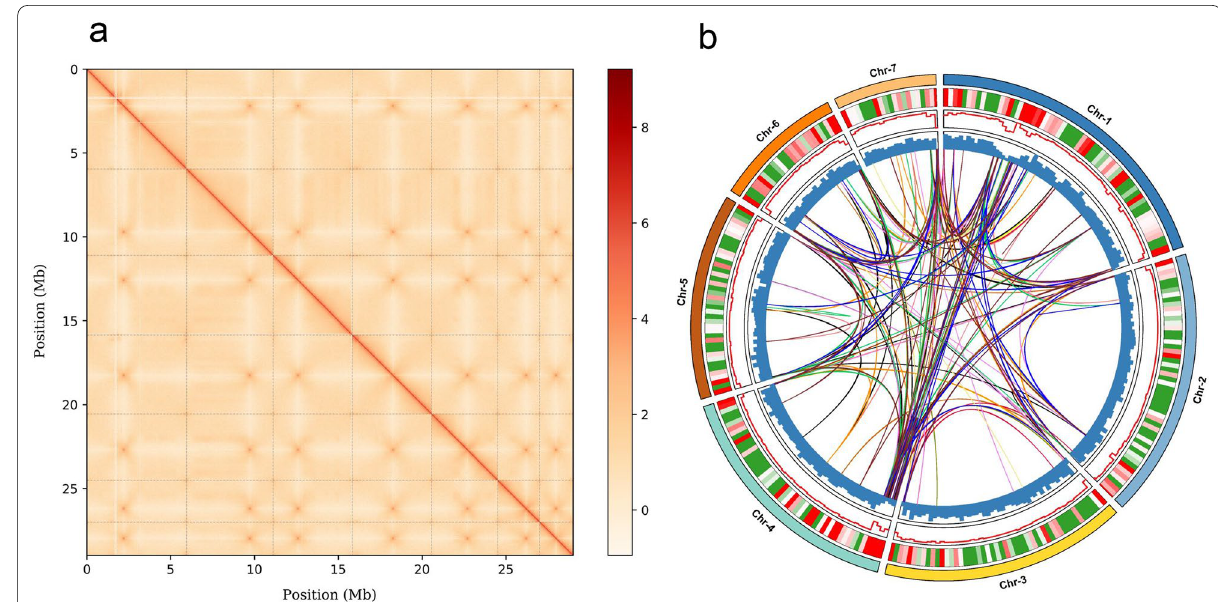
Fig. 7 Simplicillium aogashimaense genome assembly. a The Hi‑C interaction heatmap for S. aogashimaense . The color in the figure from white to red indicates the increase in the intensity of interaction. b Overview of chromosomal features of the S. aogashimaense genome. The circular layers represent the following (from outside to inside): seven chromosomes (colored layers), repeat coverage (heatmap), GC content (red lines) and gene density (blue bars). Connected lines show the linked genes in S. aogashimaense chromosomes